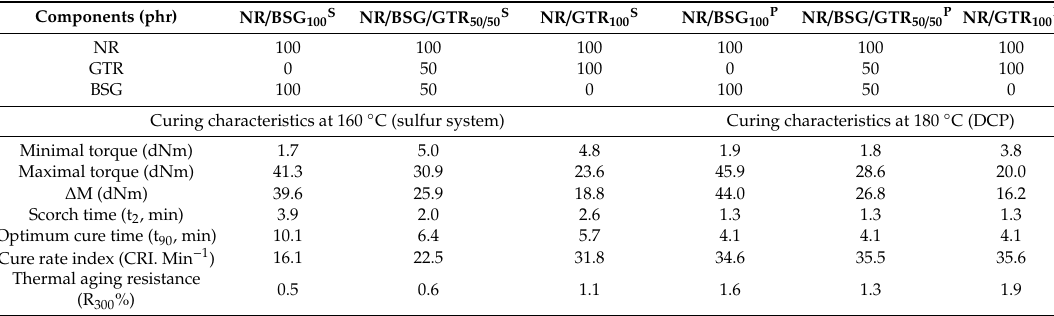
Figure 3. Curing curves for highly-filled NR / BSG / GTR composites. Table 2. Composition and curing characteristics of studied